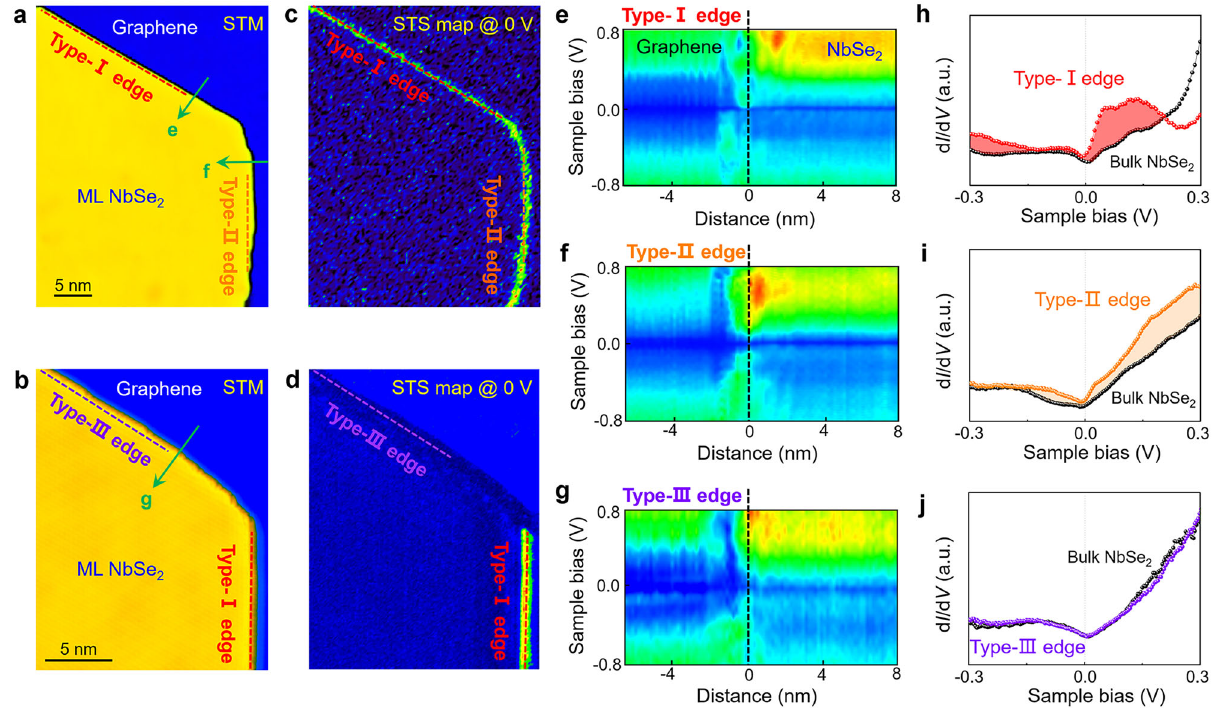
Fig. 2 Electronic properties at the zigzag (ZZ) edges in monolayer (ML) NbSe 2 . a , b Representative scanning tunneling microscopy (STM) images of ML NbSe 2 islands with ZZ edges. The island edges are marked by the dashed lines. c , d Corresponding scanning tunneling spectroscopy (STS) maps recorded at the same locations of panel a,b under the energy of 0 eV, respectively. e – g Spatially resolved STS spectra recorded across the ZZ edges that marked by the green arrows in panels a , b , respectively. The locations of the edges are highlighted by the black dashed lines. h – j Low-energy STS spectra at the edges and the bulk of ML NbSe 2 that are extracted from panels e – g , respectively. The edge states are highlighted by the